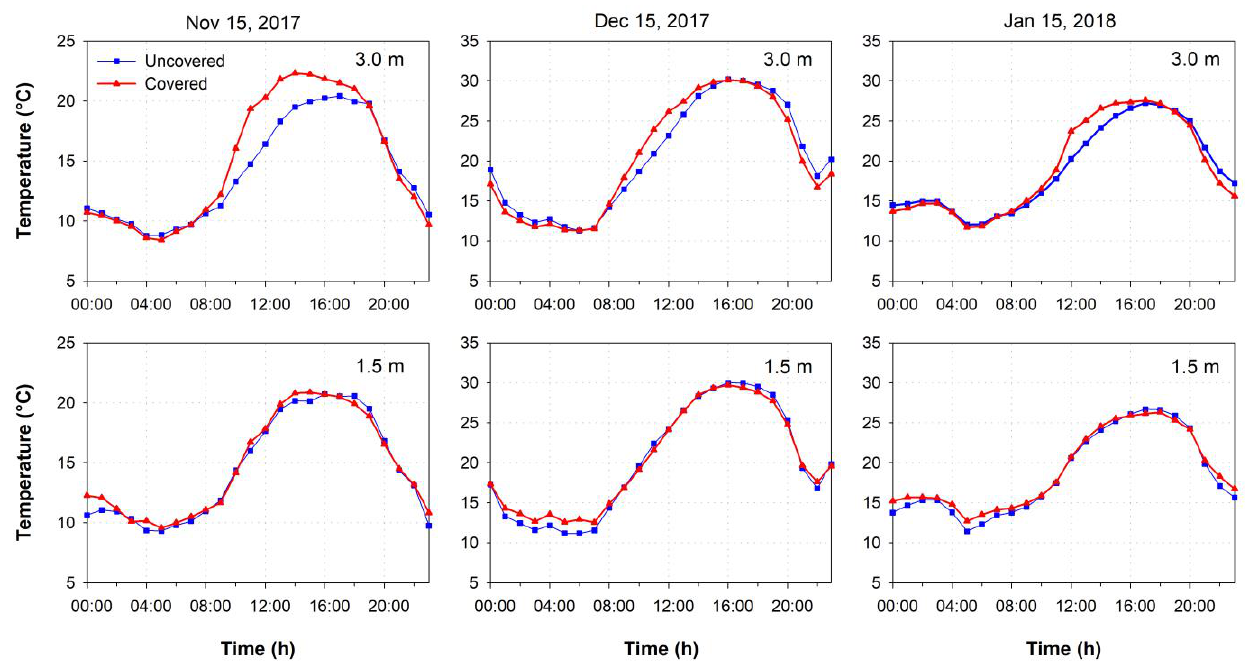
Figure 2. Daily fluctuation of air temperature with and without rain cover at 3 m ( top ) and 1.5 m ( bottom ) above the ground. Days evaluated under cloud-free conditions. Central Valley, Chile. The relative humidity at a 3 m height was significantly lower during most of the day under rain cover, compared to the control, as a consequence of the higher temperature in the upper zone; at a 1.5 m height, the differences observed between treatments were